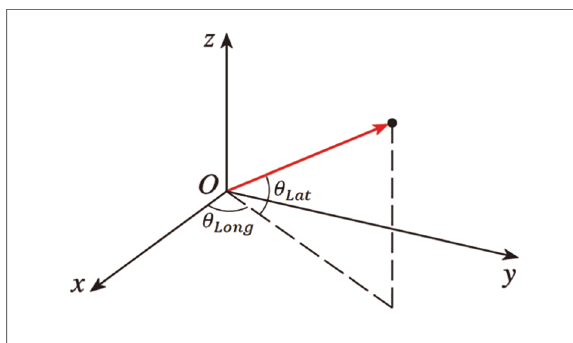
FIGURE 2 De fi nition of the latitude and longitude of a